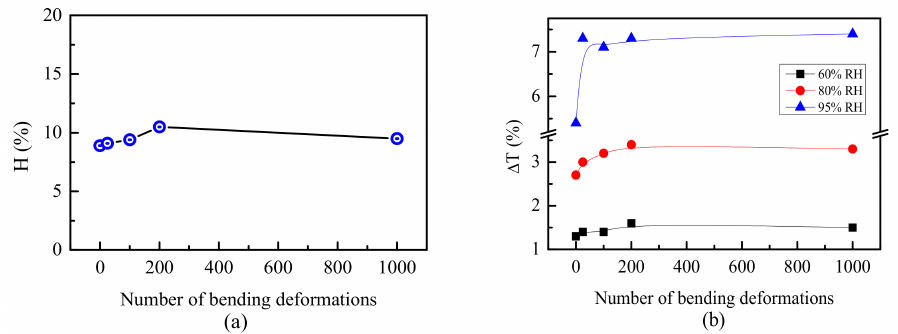
Figure 9. Percentage of hysteresis, H calculated with Equation (1) ( a ) and transmittance change ∆ T max (%) at different levels of humidity ( b ) for PET/Au:Pd/polymer sensor calculated before and after 25, 100, 200 and 1000 bending